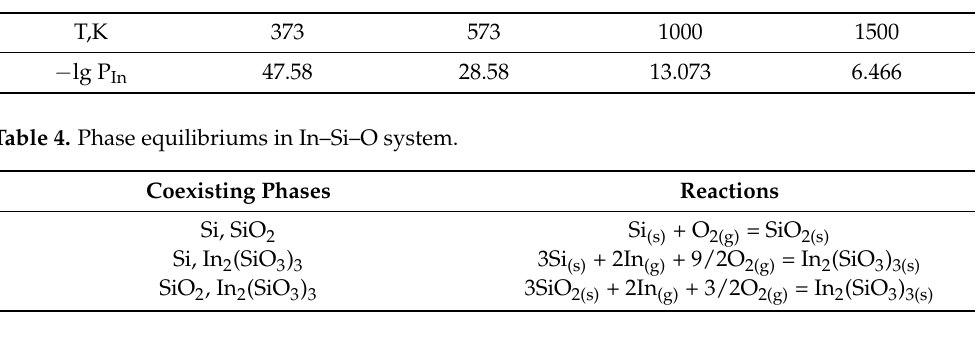
Table 3. Temperature dependency lg P In = f(T).